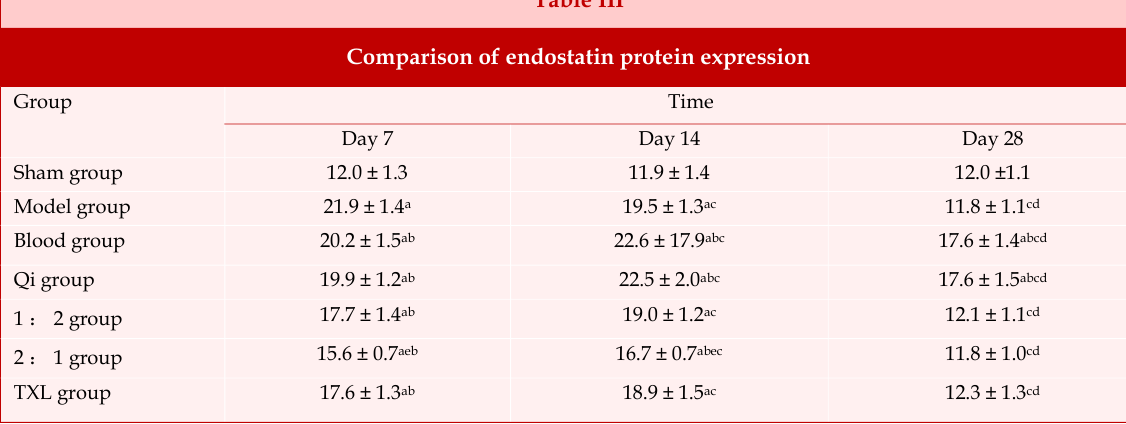
Figure 2: Vascular endothelial growth factor expression at day